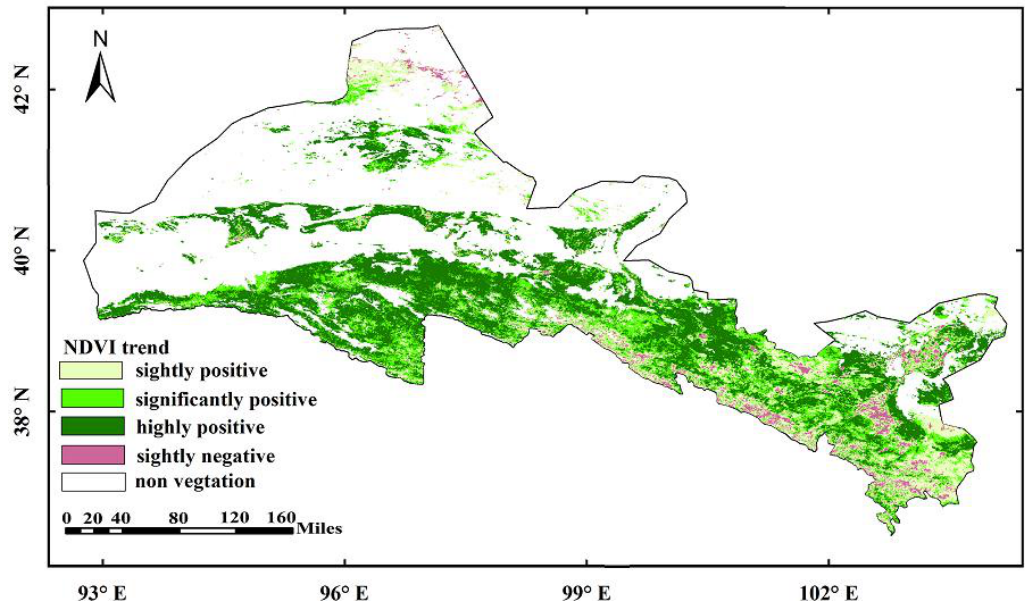
Figure 5. Spatial patterns of interannual variation trends of the growing season NDVI around the Hexi Corridor from 2000 to 2015. Remote Sens. 2018 , 10 , x FOR PEER REVIEW